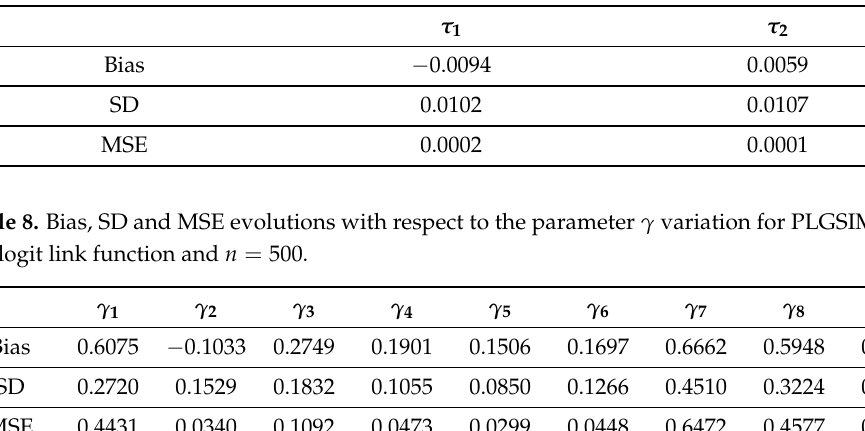
Table 7. Bias, SD and MSE evolutions with respect to the parameter τ variation for PLGSIMF with the logit link function and n = 500.